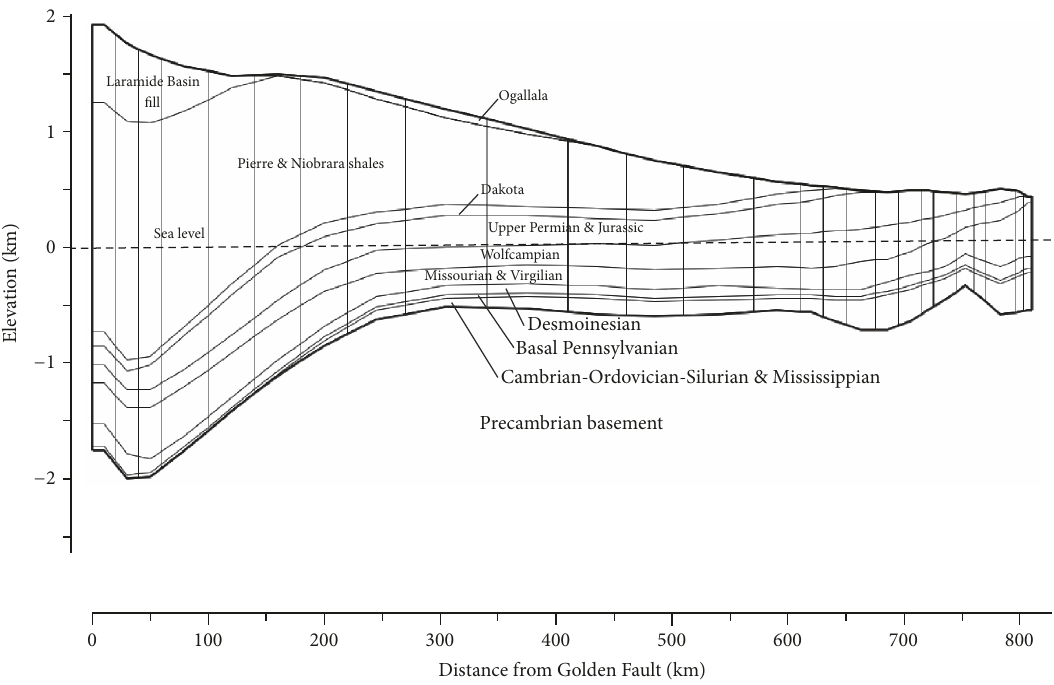
Figure 7: Present-day geologic cross-section along line A-A 󸀠 (Figure 6) with names of geohydrologic units. Modified from Nelson et al. [7]. Vertical lines are both well locations and internal model boundaries.